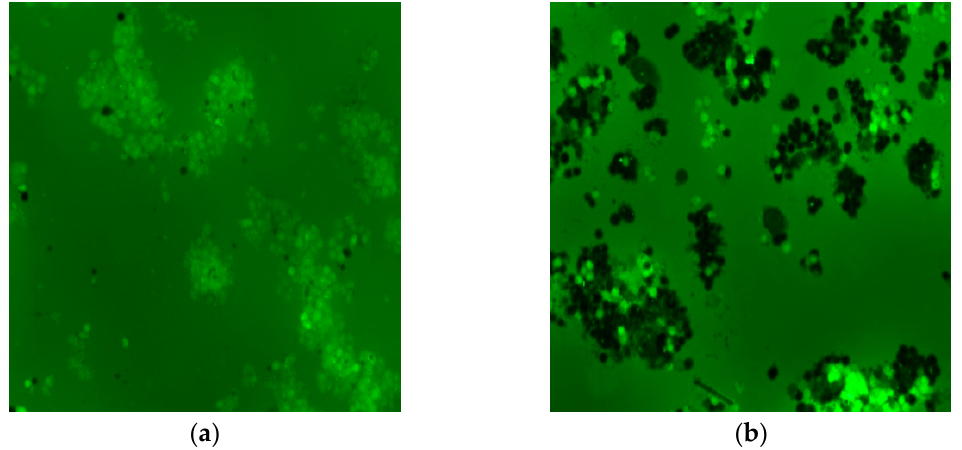
Figure 8. Microscope images of the HT-29 cells using a green light filter and the blue light source, of the labeled samples: ( a ) DCF H 2 O 2 CMNP and ( b ) DCF CMNP.